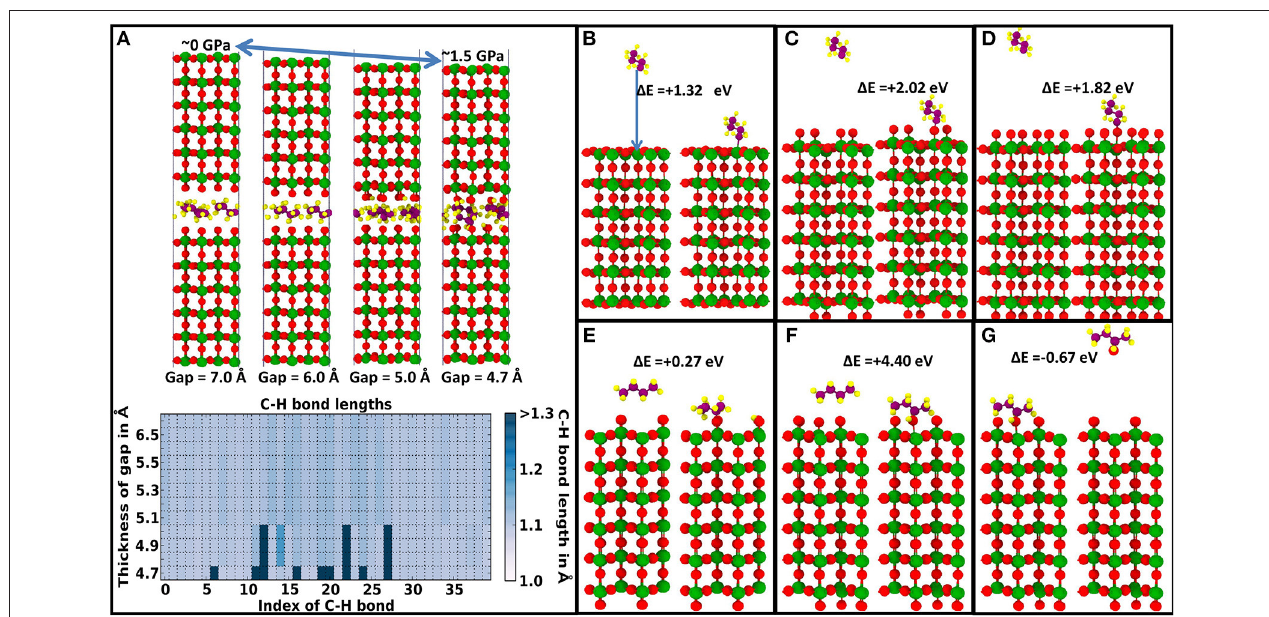
FIGURE 3 | Radicalization and adsorption of hydrocarbon molecules on WO 3 surfaces. Coloring of atoms is as follows: W atoms are green, O atoms red, H atoms yellow, and hydrocarbon C purple. (A) DFT quasi-static pressure relaxation showing the sudden elongation and breaking of some C–H bonds in butane (C 4 H 10 ) molecules with increasing pressure between reactive WO 3 surfaces. In (A) , the top panel shows selected snapshots with decreasing interface gap (i.e., increasing pressure), while the bottom panel depicts the elongation of each C–H bond with decreasing interface gap. Adsorption of a CH 2 -C 3 H 7 radical (an H missing at the tail) on (B) an oxygen-deficient purely W-terminated WO 3 (100) surface, (C) a stoichiometrically (i.e., ½ ML O-ion coverage) oxygen-saturated WO 3 (100) surface, and (D) a fully oxygen-saturated WO 3 (100) surface. Generation of a C 2 H 5 CHCH 3 radical (a missing H atom in the interior) and its adsorption after dissociation of an H atom from a C 4 H 10 molecule on (E) a stoichiometrically O-terminated (i.e., ½ ML O-ion coverage) WO 3 (100) surface and (F) a WO 3 (100) surface with one more O-ion than stoichiometrically necessary (i.e., ½ ML + 1 O-ion coverage). (G) Desorption energy of a C 4 H 9 OH molecule from a WO 3 surface with ½ ML + 1 O oxygen [after the adsorption event shown in (F)